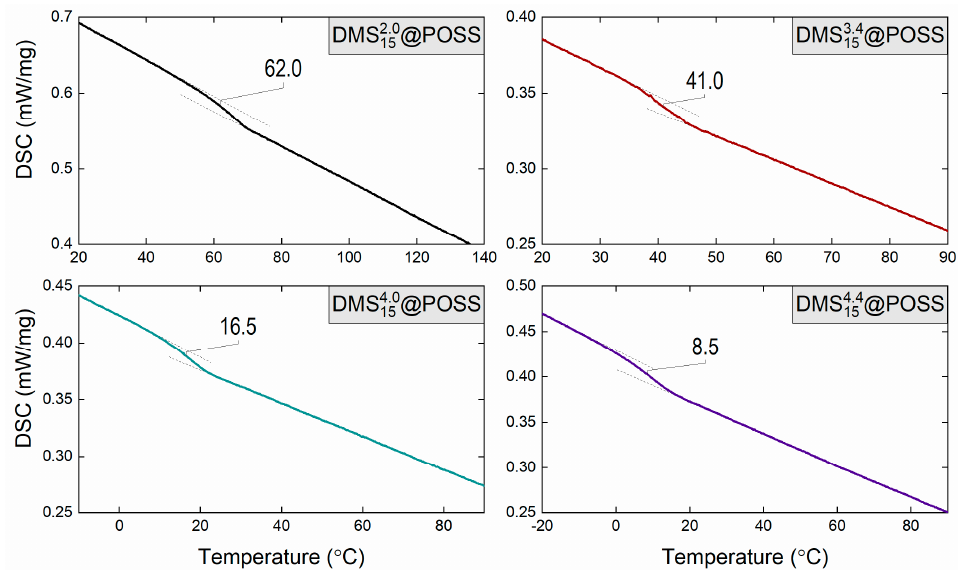
Figure 4. Dynamic scanning calorimetry results obtained for the DMS x y @POSS composite membranes demonstrating clear glass transition behavior (T g indicated on each plot) which correlates with the material composition, namely higher T g corresponds to higher amount of POSS in material. Table 2. Glass transition temperatures of the DMS x y @POSS composite membranes measured by thermal mechanical analysis (TMA) and dynamic scanning calorimetry (DSC). T g , ◦ C Material by